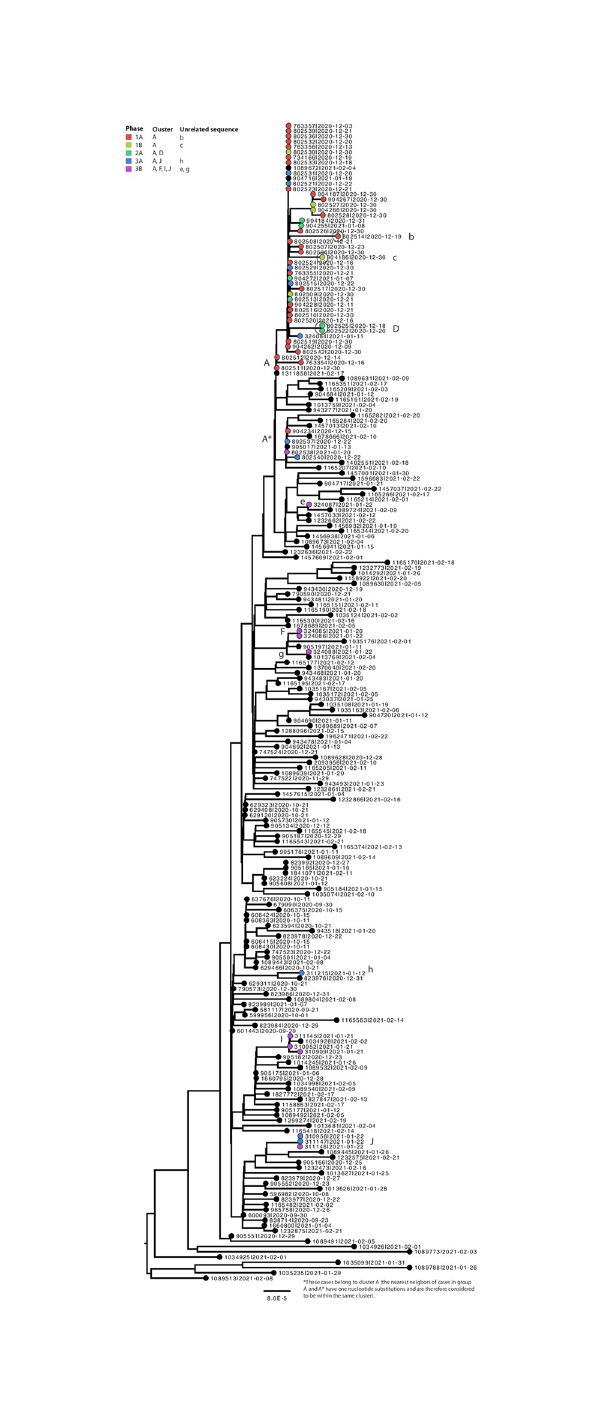
Fig 2. Maximum likelihood analysis of 60 Alpha variant SARS-CoV-2 whole genome sequences obtained from individuals living in the municipality Lansingerland, the Netherlands, or with an epidemiological link to School X or neighbouring schools and child care centres from December 30 th 2020 to January 22 nd 2021, in a background of 140 Alpha variant sequences obtained from the Netherlands from November 29 th 2020 until February 22 th 2021 and 20 Alpha variant sequences from the United Kingdom from September 21 th until October 21 th 2020 (black). Colours indicate the study phase in which specimens were collected. Scale bar represents the number of nucleotide substitutions per site. The text next to each sequence indicates the GISAID accession id and sample collection date.